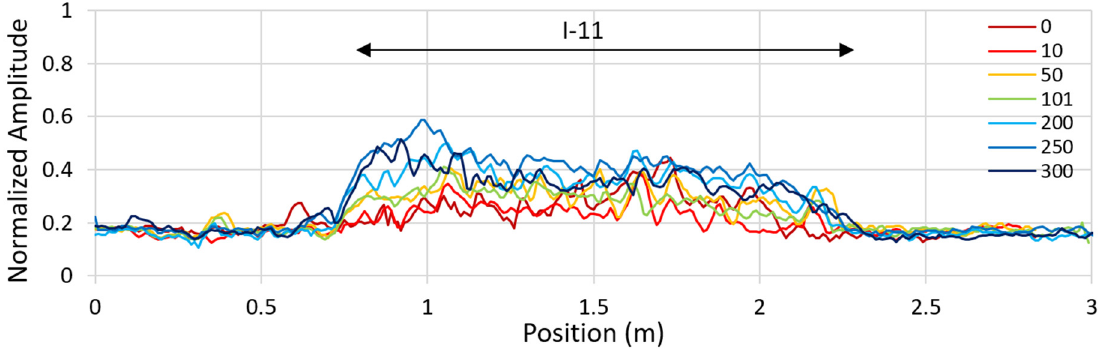
Figure A5. 2.6 GHz normalized RW amplitudes on sand (I-11) in the longitudinal direction vs. K loadings.